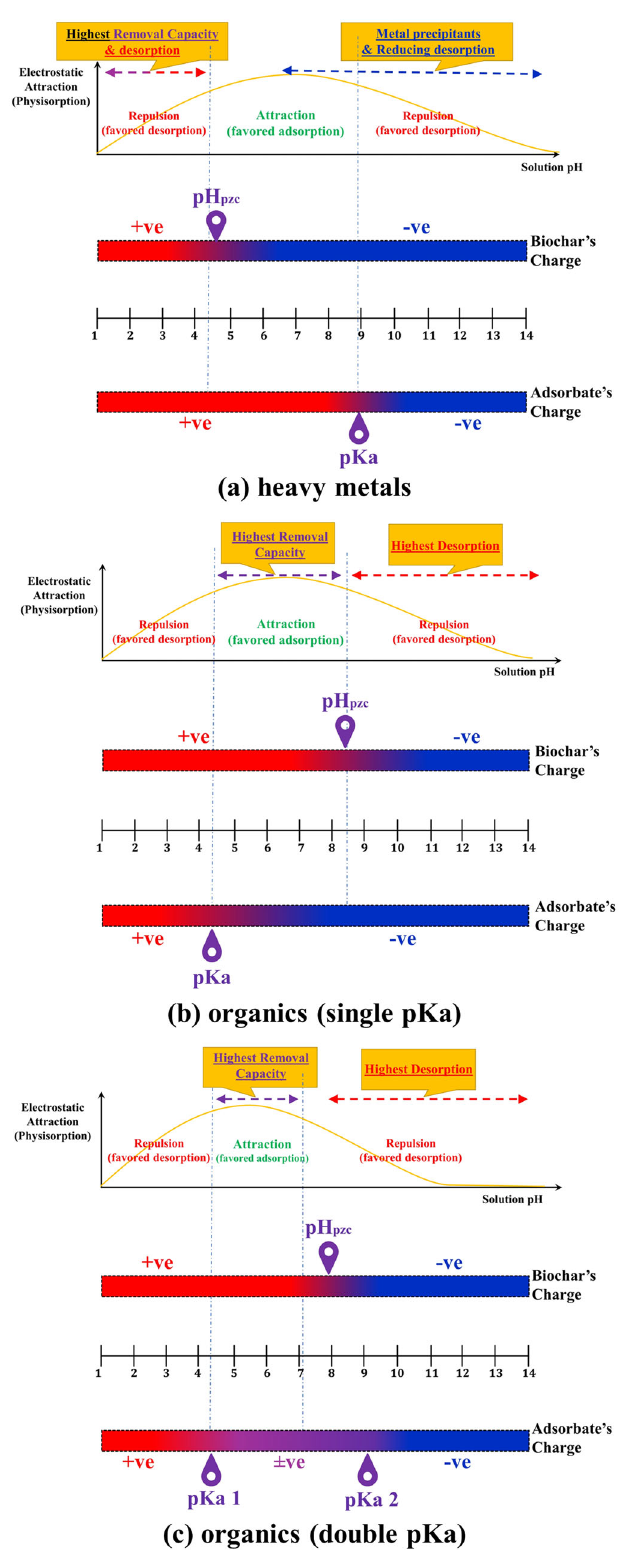
Fig. 6 Mutual effect of pH, pKa, and pH pzc on adsorption and desorption. Effect of solution pH, adsorbate pKa, and biochar pHpzc on adsorption/desorption